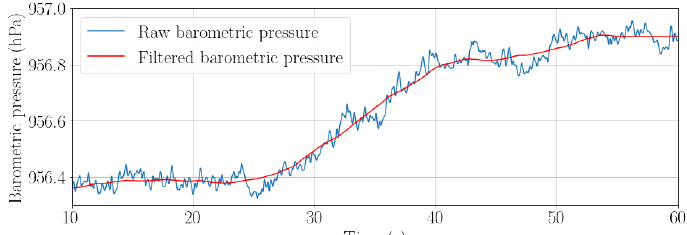
Figure 10. Raw (blue) and filtered (red) barometric pressure recorded while a passenger is climbing a